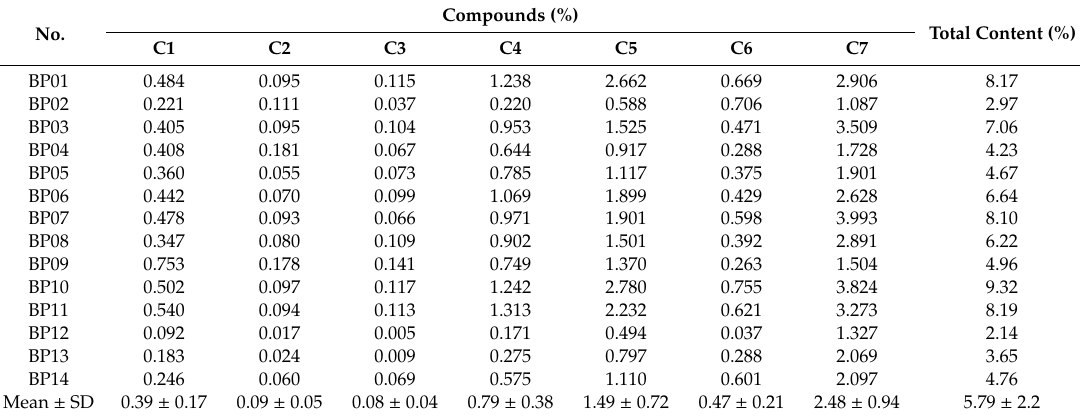
Table 3. Determination of seven phenolic acids compounds obtained from fourteen Brazilian green propolis